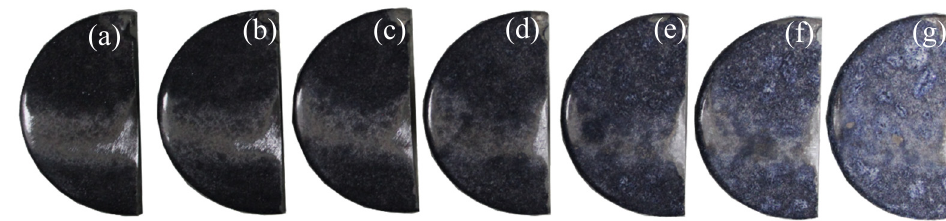
Figure 9. Wear morphology of MAO coating: ( a ) S0; ( b ) S1; ( c ) S2; ( d ) S3; ( e ) S4; ( f ) S5; and ( g ) S6.